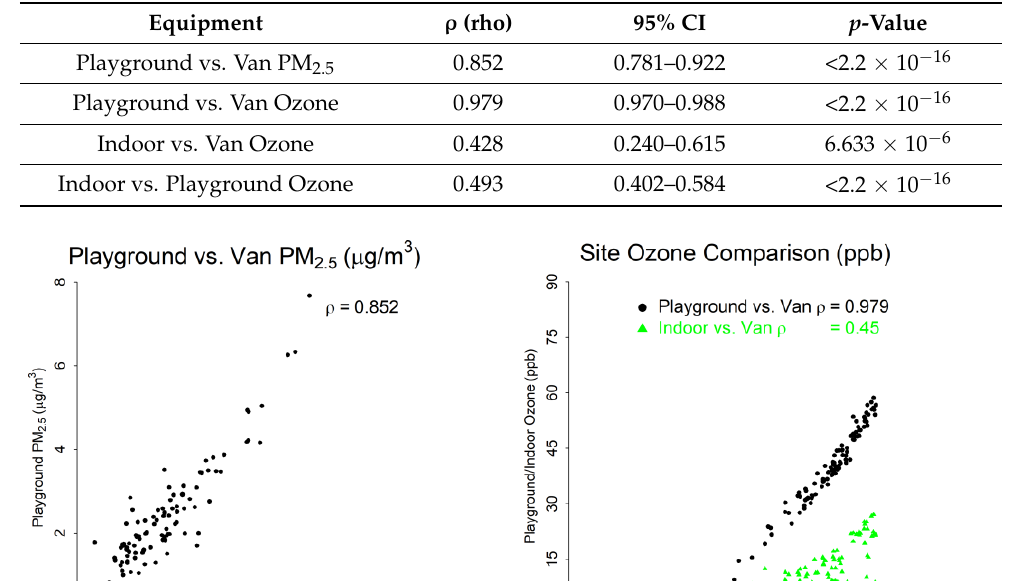
Table 6. Bonneville Phase 1 Spearman correlation test results for site pollutant readings.